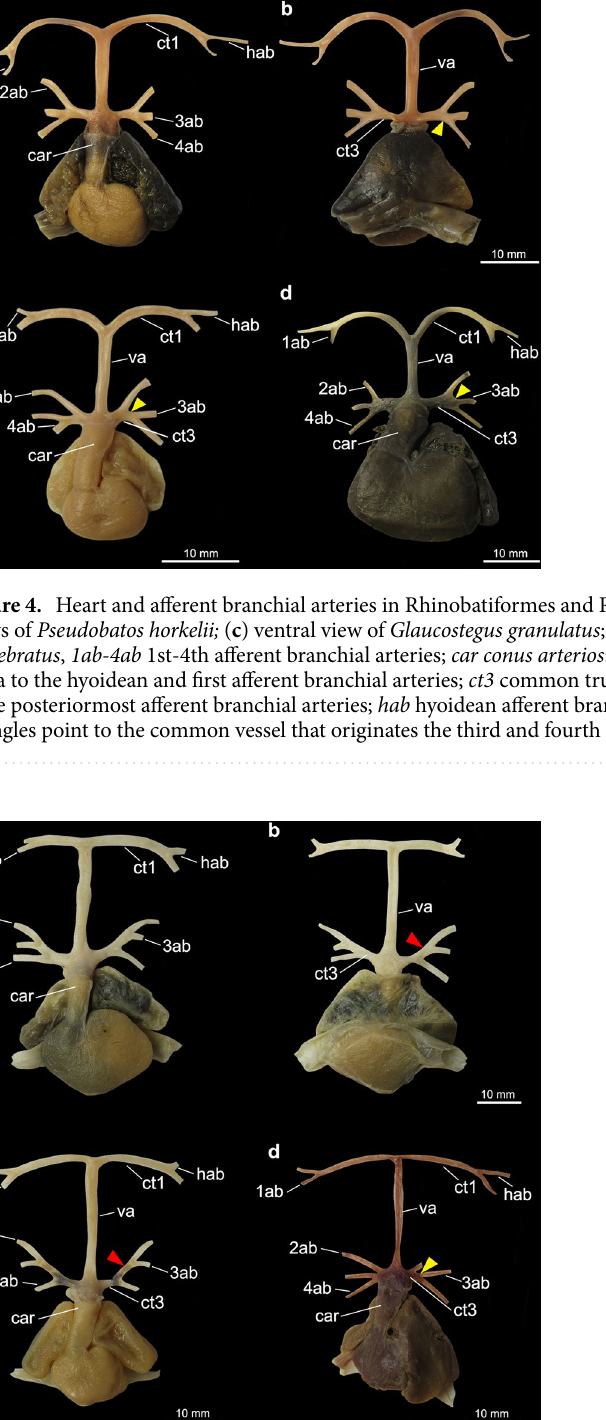
Figure 5. Heart and afferent branchial arteries in Rajiformes. ( a ) ventral and ( b ) dorsal views of Atlantoraja cyclophora ; ( c ) ventral view of Rioraja agassizii ; ( d ) ventral view of Sympterygia acuta . 1ab-4ab 1st-4th afferent branchial arteries; car conus arteriosus ; ct1 common trunk from the ventral aorta to the hyoidean and first afferent branchial arteries; ct3 common trunk from the ventral aorta to the three posteriormost afferent branchial arteries; hab hyoidean afferent branchial artery; va ventral aorta. Red triangles point to the common vessel that originates the second and third arteries and yellow one to the common vessel to third and fourth afferent branchial